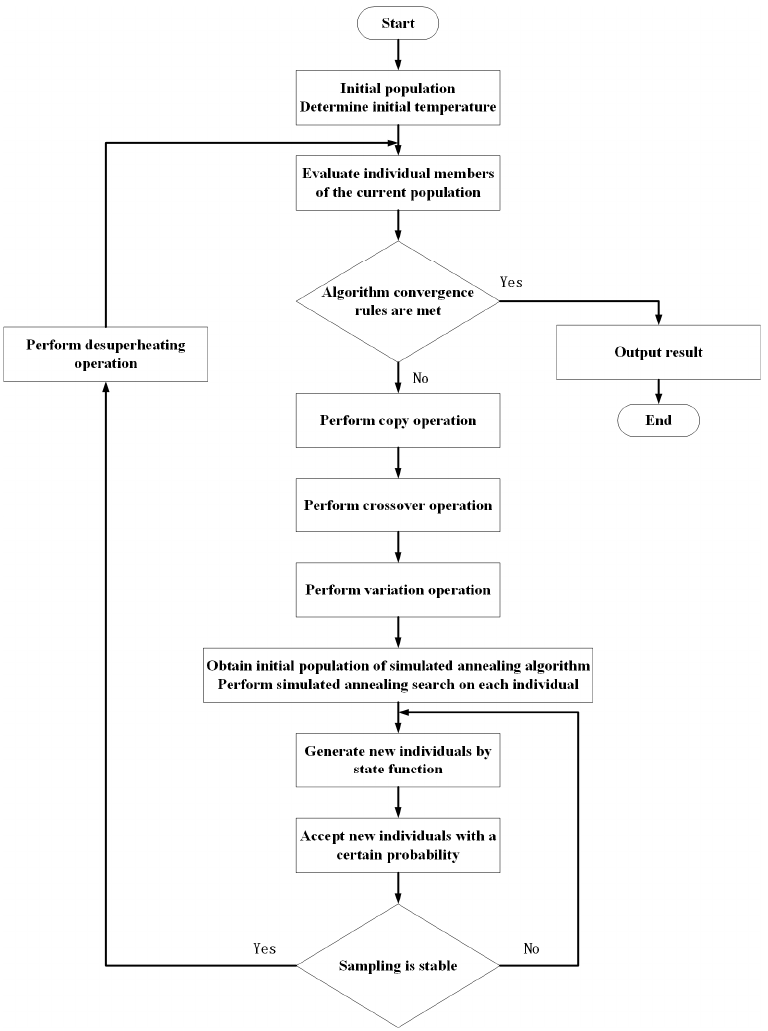
Figure 9. Flowchart of the GA-SA hybrid optimization algorithm.